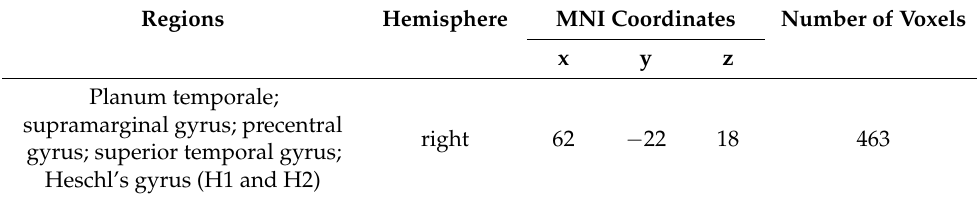
Figure 6. Voxel-based morphometry analyses, in left-lateralised semantic dementia, right-lateralised semantic dementia and controls combined, showing brain regions where reduced grey matter inten- sity correlated with more fixations to the eyes. Coloured voxels show regions that were significant in a voxel-wise analysis at p < 0.005, uncorrected, with a cluster extent threshold of 150 voxels. R = right; L = left. MNI coordinates: x = 55, y = − 22, z = 13. Table 3. Voxel-based morphometry results showing significant negative correlation between grey matter intensity and fixations to the eyes in all semantic dementia patients and controls